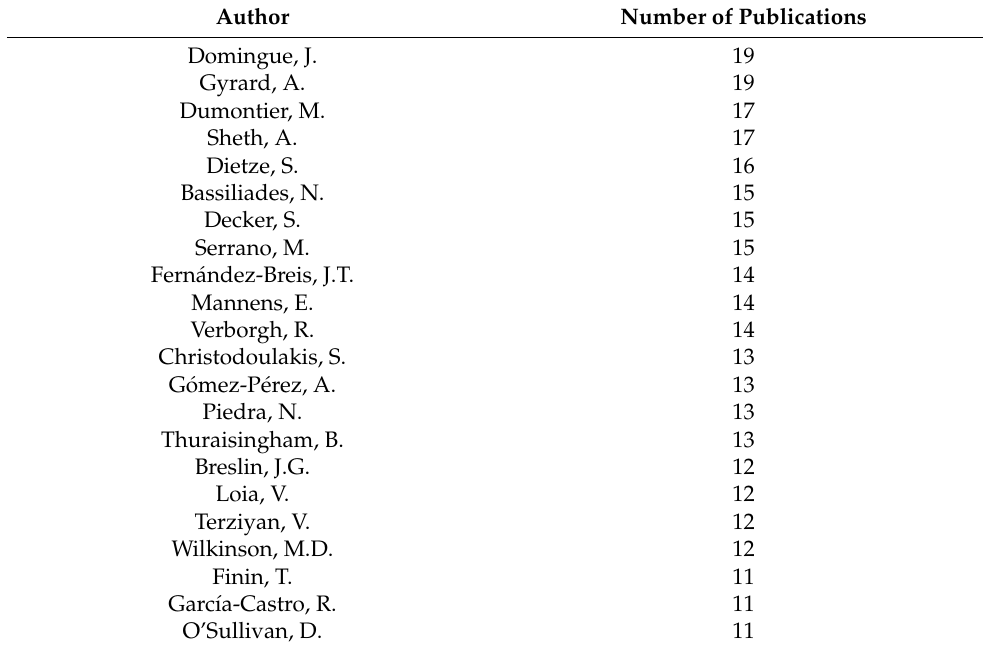
Table 5. Top 20 most productive